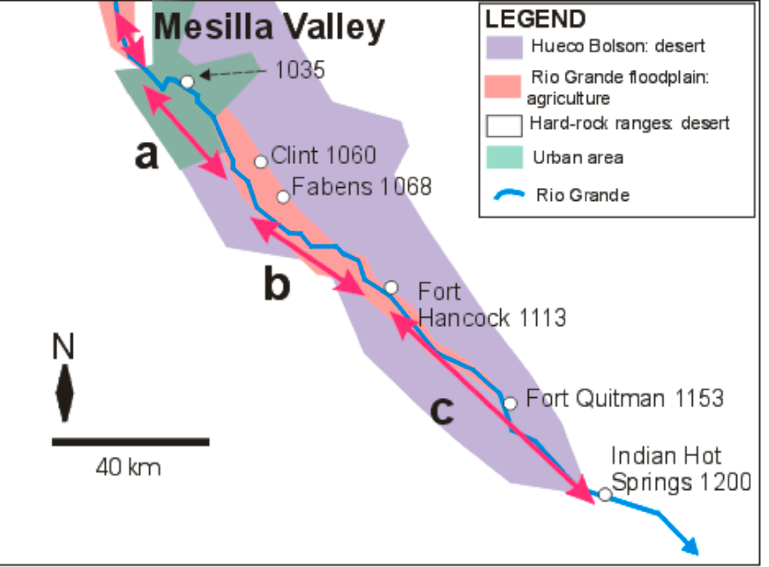
Figure 9. Map of the study area showing the river reaches in which of mixing trends a, b and c (Figure 7) occur, relative to land use zones. Numbers such as 1035 indicate km from the river